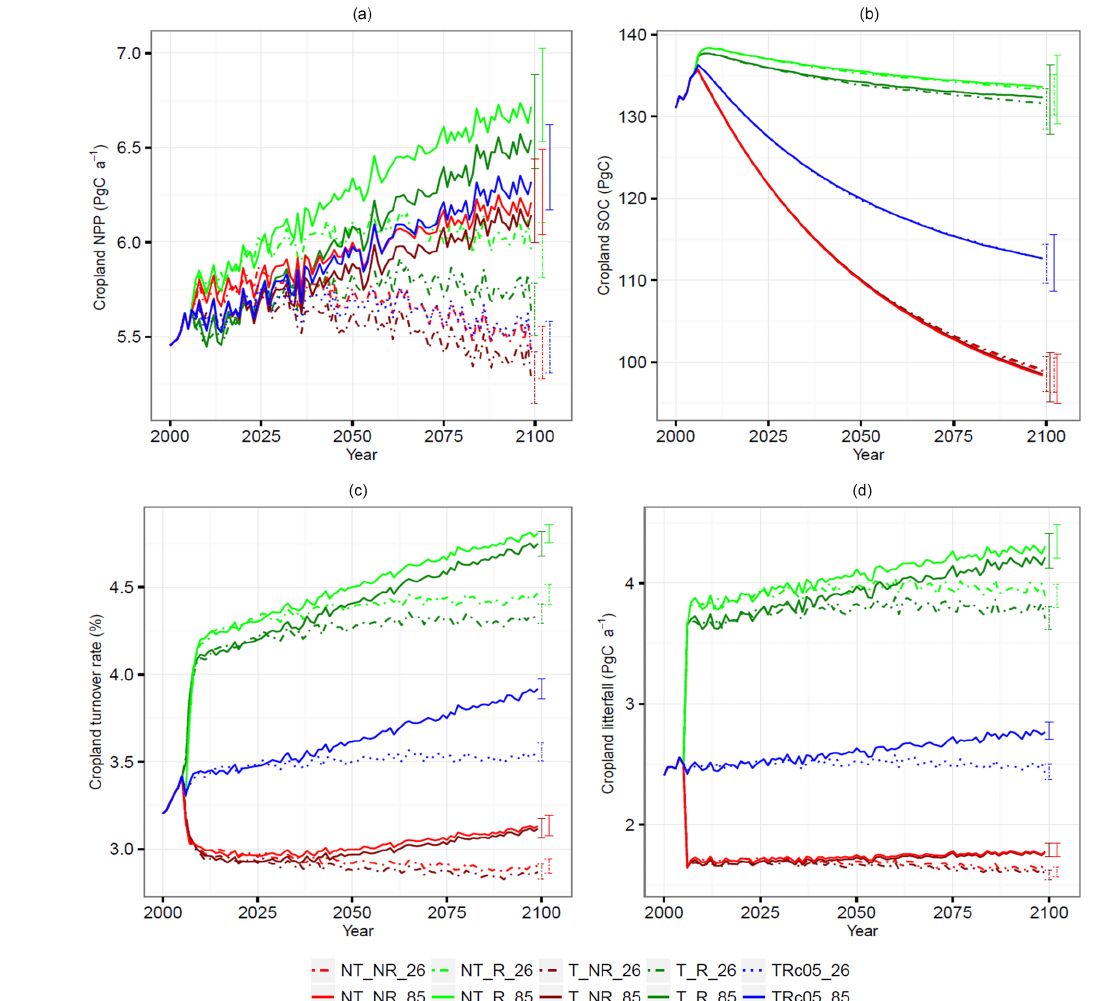
Figure 3. Global sums for cropland for NPP (a) , SOC (b) , turnover rate (c) , and litterfall (d) from 2000–2005 for default management inputs and from 2006–2099 under constant cropland area of 2005 for five different management scenarios and two RCPs. Presented are the mean values across all four GCMs as lines. The spread across all GCMs is depicted as bars in the year 2100. The numbers _26 and _85 describe the climate forcing RCP2.6 (e.g., TRc05_26) and RCP8.5 (e.g., TRc05_85). Green: residues retained (R), red: residues removed (NR), dashed: RCP2.6, solid: RCP8.5, light color: no till (NT), dark color: tillage (T). Tillage and residue management are held constant at 2005 level in TRc05: tillage and residues left on the field (T_R), tillage and residues removed (T_NR), no till plus residues left on the field (NT_R), and no till and residues removed (NT_NR). Dynamics prior to 2005 (all scenarios equal) mostly show the expansion of cropland until 2005 so that total SOC increases because the area increases. Turnover rates between 2000 and 2005 increase because decomposition rates are high on freshly deforested